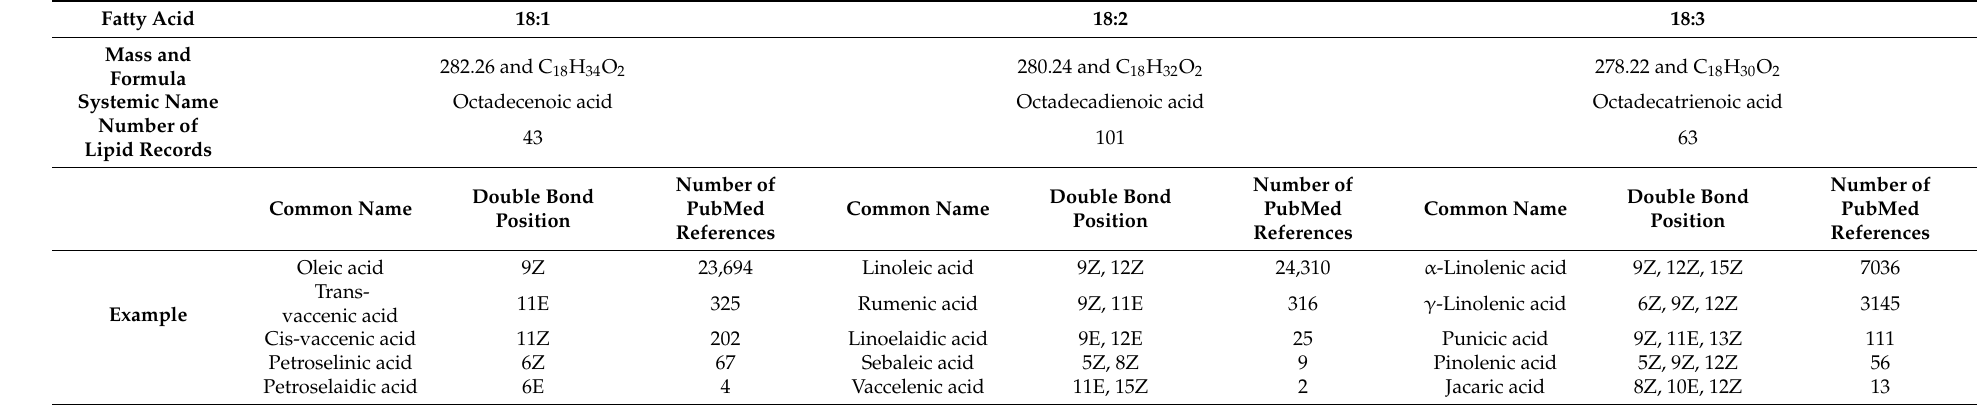
Table 1. The importance of the double bond